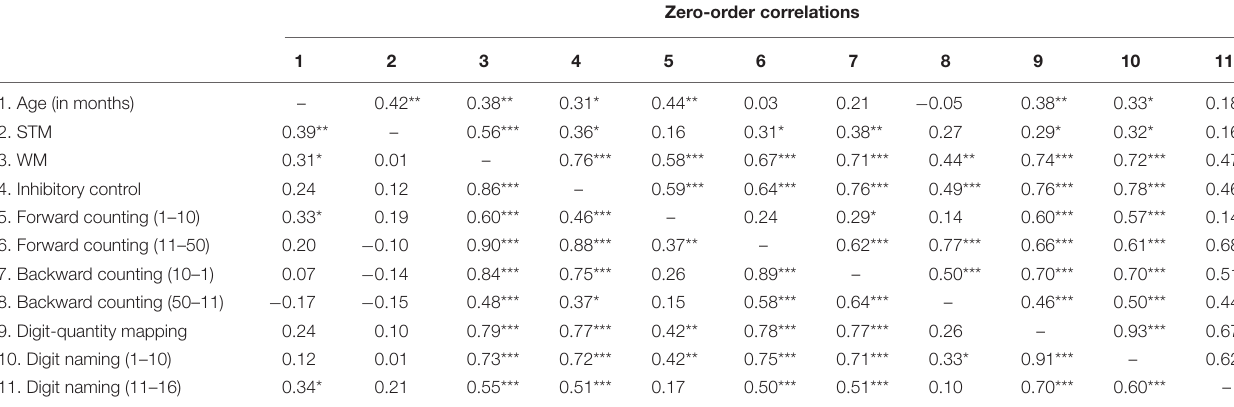
TABLE 2 | Bivariate correlations between all variables considered in the study for Yazidi ( n = 48) and Syrian refugee ( n = 47) children.